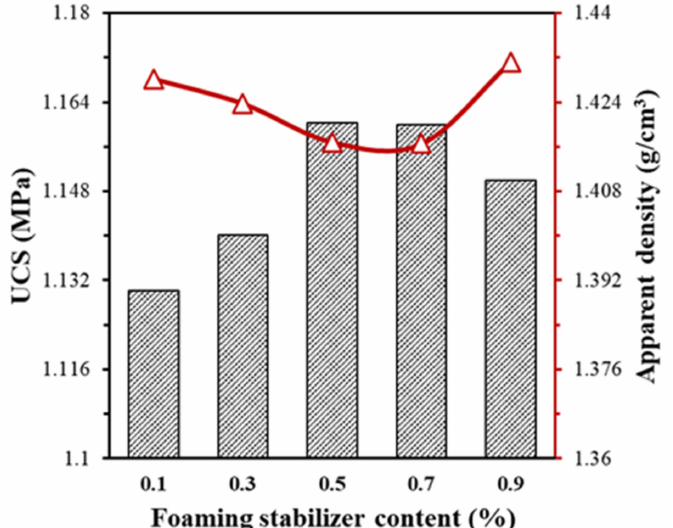
Figure 6. Effect of foaming stabilizer on UCS and apparent density.